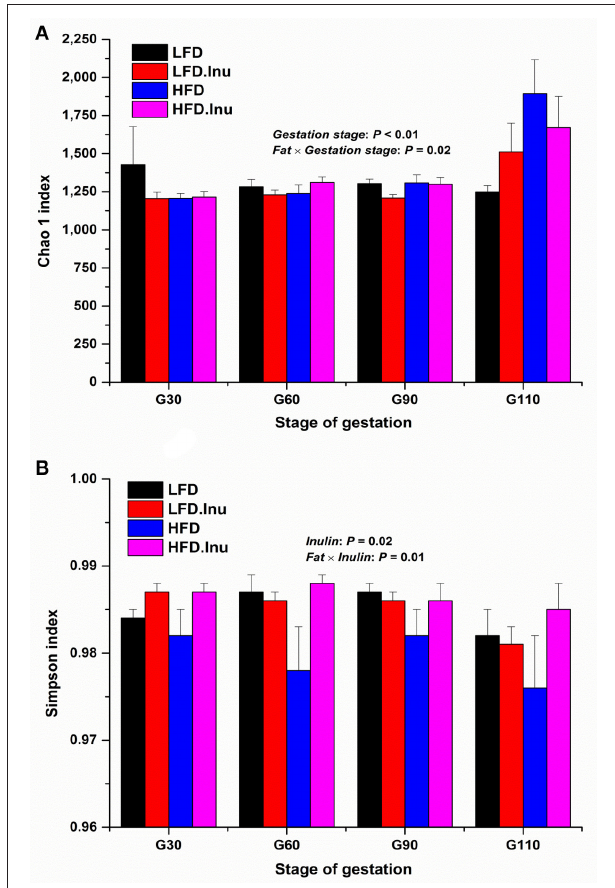
FIGURE 4 | (A) Chao 1 and (B) Simpson index analyses over the course of gestation. Sows were regarded as the experimental units, n = 5 for each treatment at each gestation stage except for LFD group on d90 and d110 with n = 4 due to an unexplained diarrhea on d88 of gestation which lasted for 2days. (A) Chao 1 index: P < 0.01 and P = 0.02 for gestation stage and fat × gestation stage interaction effect, respectively. (B) Simpson index: P = 0.02 and P = 0.01 for inulin and fat × inulin interaction effect, respectively. When significant main effects or interative effects were observed, the means were compared using the least significant difference method with a P < 0.05 indicating significance. Therefore, mean values without a common letter are significantly different for each parameter in the figure ( P < 0.05). LFD, low fat diet; LFD.Inu, low fat diet with inulin addition; HFD, high fat diet; HFD.Inu, high fat diet with inulin addition. Only significant p values were presented in the